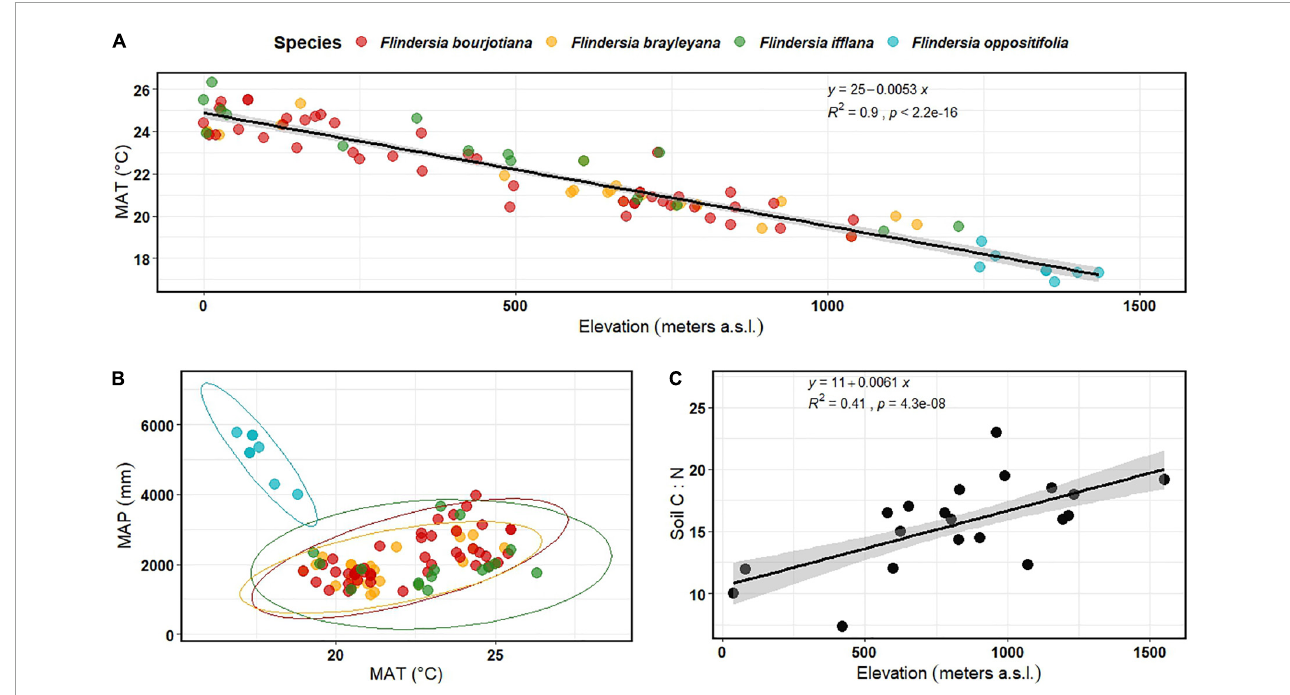
FIGURE1 (A) Variation in mean annual temperature (MAT) across elevation in the Australian Wet Tropics, based on the Flindersia species occurrence records obtained after spatial thinning at 0.5 km resolution and interpolated using WorldClim v.2 bioclimatic variables (MAT, BIO1) ( n = 95); (B) Scatter plot of mean annual precipitation (MAP, BIO12) as a function of mean annual temperature (MAT, BIO1), with ellipses representing species’ climate niche across the occurrence range of the four focal Flindersia species within the Australian Wet Tropics ( n = 95); (C) Variation in soil C:N ratio across an elevation gradient in the Australian Wet Tropics measured during this study ( n =